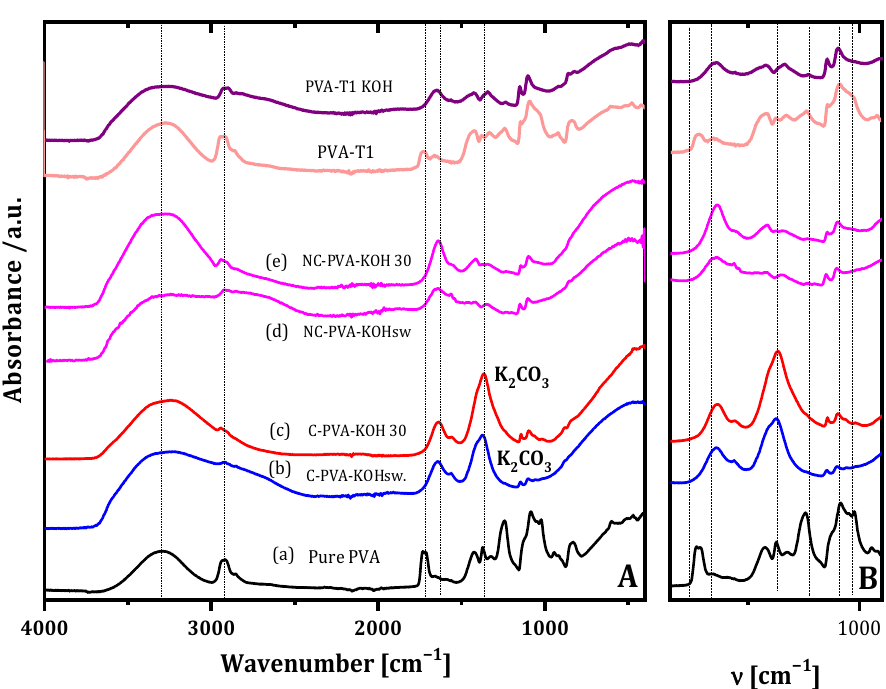
Figure 5. ( A ) ATR-FTIR spectra of pure PVA ( a ) PVA-KOH ( b ) and PVA-KOH immersed in 12 M KOH solution ( c ) synthesized in the presence of carbon dioxide; PVA-KOH ( d ) and PVA-KOH immersed in 12 M KOH solution ( e ) synthesized in the absence of carbon dioxide; and PVA-T1 and PVA-T1 KOH membranes synthesized in the presence of carbon dioxide; ( B ) depicts the K 2 CO 3 vibration region. Sw indicates that PVA-KOH was swelled in KOH 12 M solution.